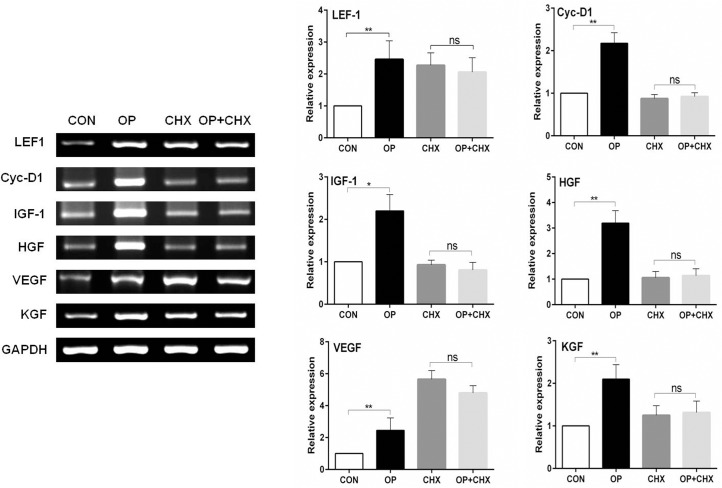
Effects of cycloheximide on gene expression changes in DPCs induced by oleuropein treatment.DPCs were allowed to attach overnight and then treated (60 min) with cycloheximide (10 μg/ml) and thereafter switched to medium with or without oleuroepin (20 μM) in the presence of cycloheximide (10 μg/ml) for 24 h. mRNA expression levels of LEF1, Cyc-D1, IGF-1, HGF, VEGF, and KGF were measured by RT-PCR. A representative image of triplicate experiments is shown in the left panel. The right panel shows the intensity of the bands that were densitometrically measured and normalized against the mRNA expression level of GAPDH. The RT-PCR results are the mean ± SD from duplicates of three independent experiments. ns = P > 0.05, * = p < 0.05, ** = p < 0.01 (student’s t-test).